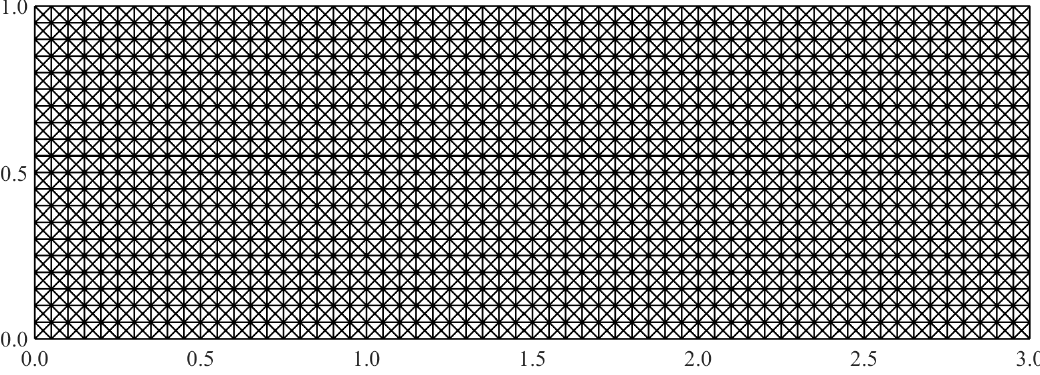
Figure 18. The iFEM mesh used for the iMIN3 element. Table 2. Strain data information for each sparse sensor configuration and inverse element.